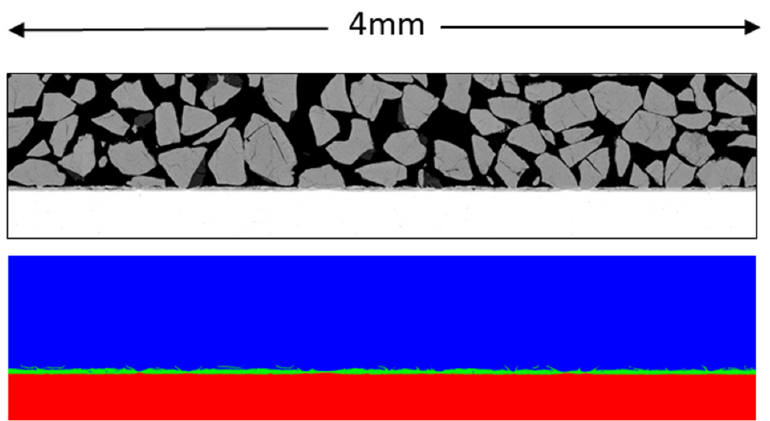
Figure 6. An example showing the back-scattered SEM image of 10CrMo9-10 cross-section (upper) and (lower) the colored cross-section of the same image showing the green-colored oxide layer between the metal (red) and deposit-epoxy mixture (blue).